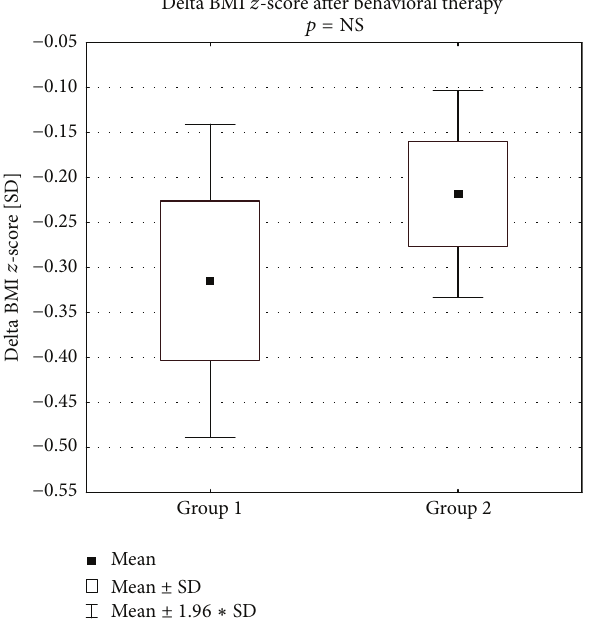
Figure 3: Change of the nutritional status (by delta BMI 𝑧 -score) at the follow-up